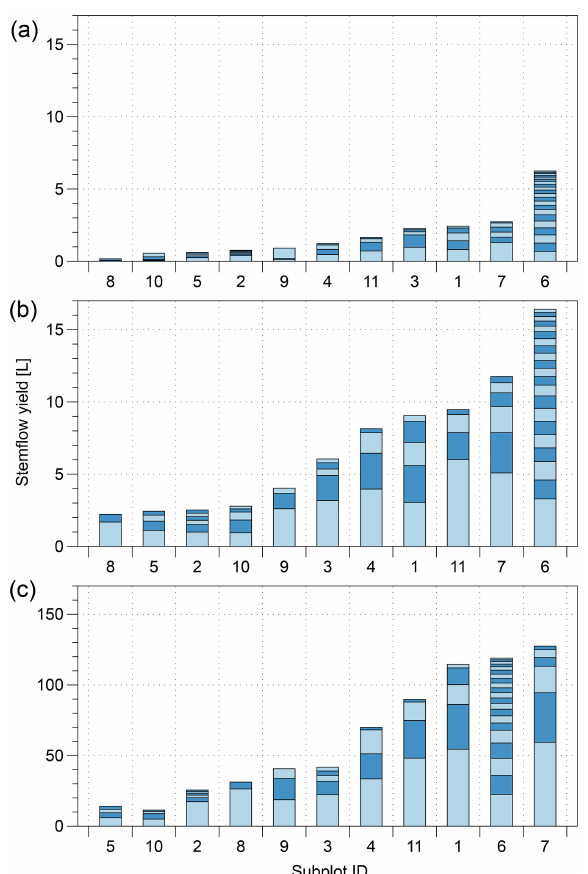
Figure 3. Ranked cumulated subplot of stemflow (bars) per event for each event size class: a small, < 5mm; b medium, 3–10mm; and c large, > 10mm. The contributions of individual trees are also shown (alternating light and dark blue sections of each